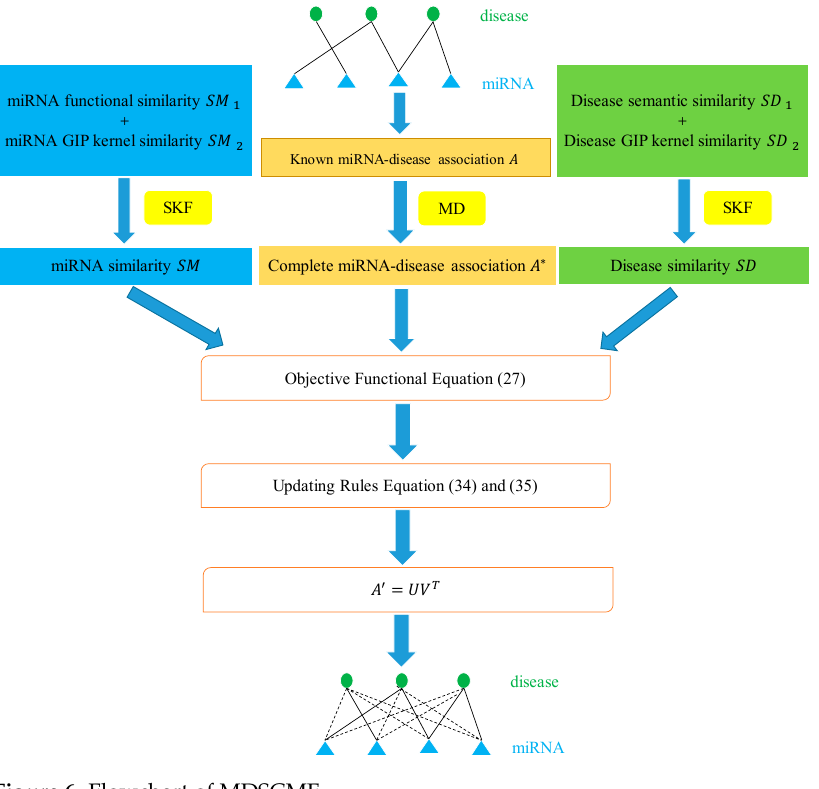
Figure 6. Flowchart of MDSCMF.